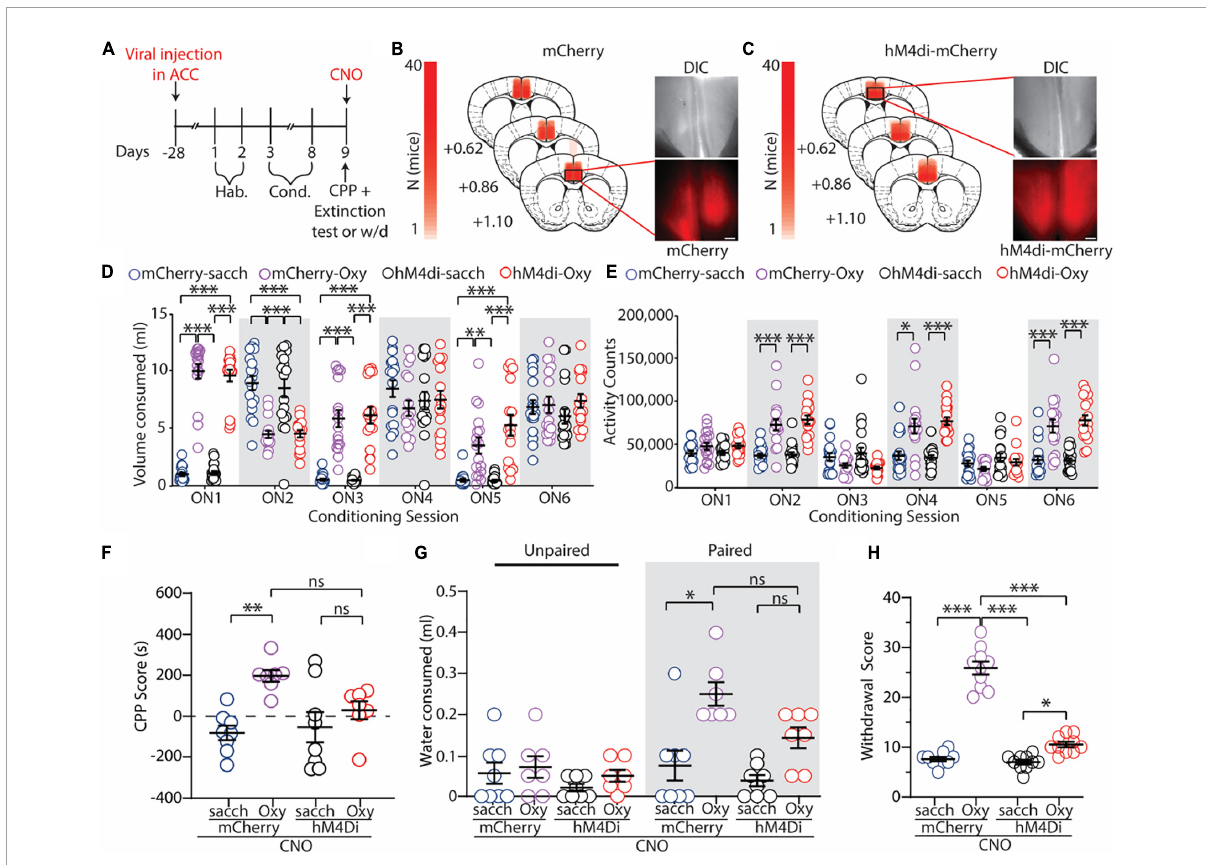
FIGURE2 Global inhibition of the ACC attenuates oxycodone-induced CPP, context-induced drug seeking, and spontaneous opioid withdrawal. (A) Timeline of the experimental paradigm. (B,C) Summary demonstrating viral injection placements in mCherry (B) and hM4di-expressing (C) mice. Scale bars = 200 µ m. (D) Summary graph showing the volume of solution consumed between groups during overnight conditioning sessions (ON1-6) [ F ( 15 , 330 ) = 29.47; p < 0.0001; two-way repeated measures ANOVA with Bonferroni post hoc test] (mCherry-sacch: n = 18; mCherry-Oxy: n = 17; hM4di-sacch: n = 18; hM4di-Oxy: n = 17). (E) Summary graph showing the locomotor activity counts across conditioning sessions [ F ( 15 , 330 ) = 15.24; p < 0.0001; two-way repeated measures ANOVA with Bonferroni post hoc test] (mCherry-sacch: n =